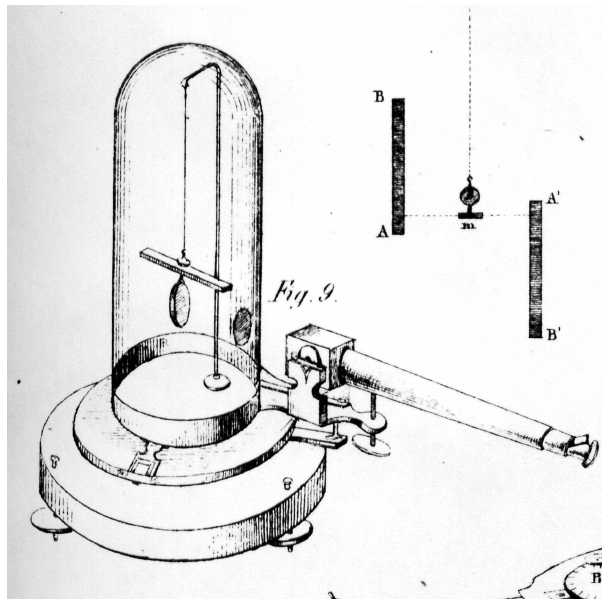
Figure 3. Lamont’s instruments with small magnets, protected by a glass cover from air turbulences. The device developed by Lloyd for the measurement of the inclination using rods of soft iron is shown on the upper right side of the figure.